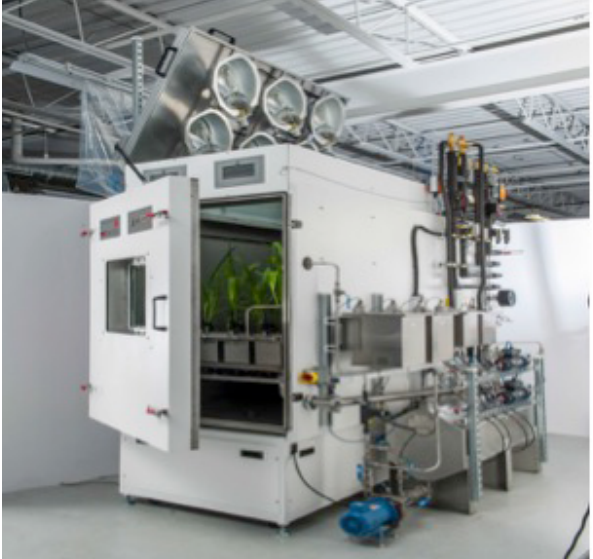
Figure 4: Guelph Bluebox sealed environment chamber designed for precision measurement of plant productivity, photosynthesis and evapotranspiration as it relates to rapid phenotype